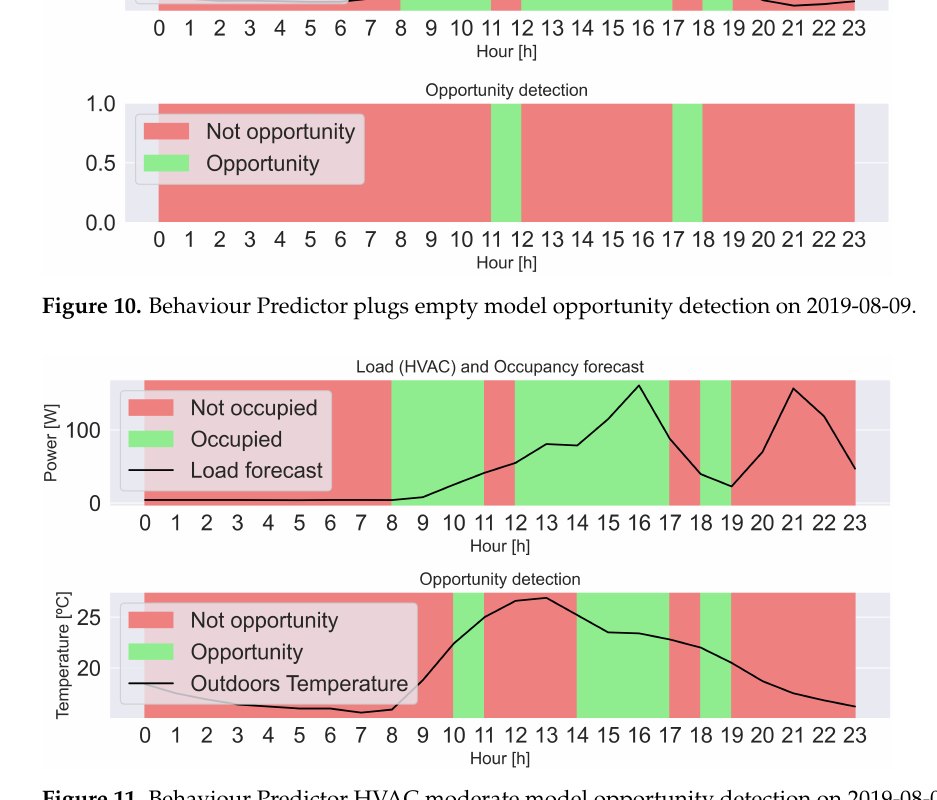
Figure 11. Behaviour Predictor HVAC moderate model opportunity detection on